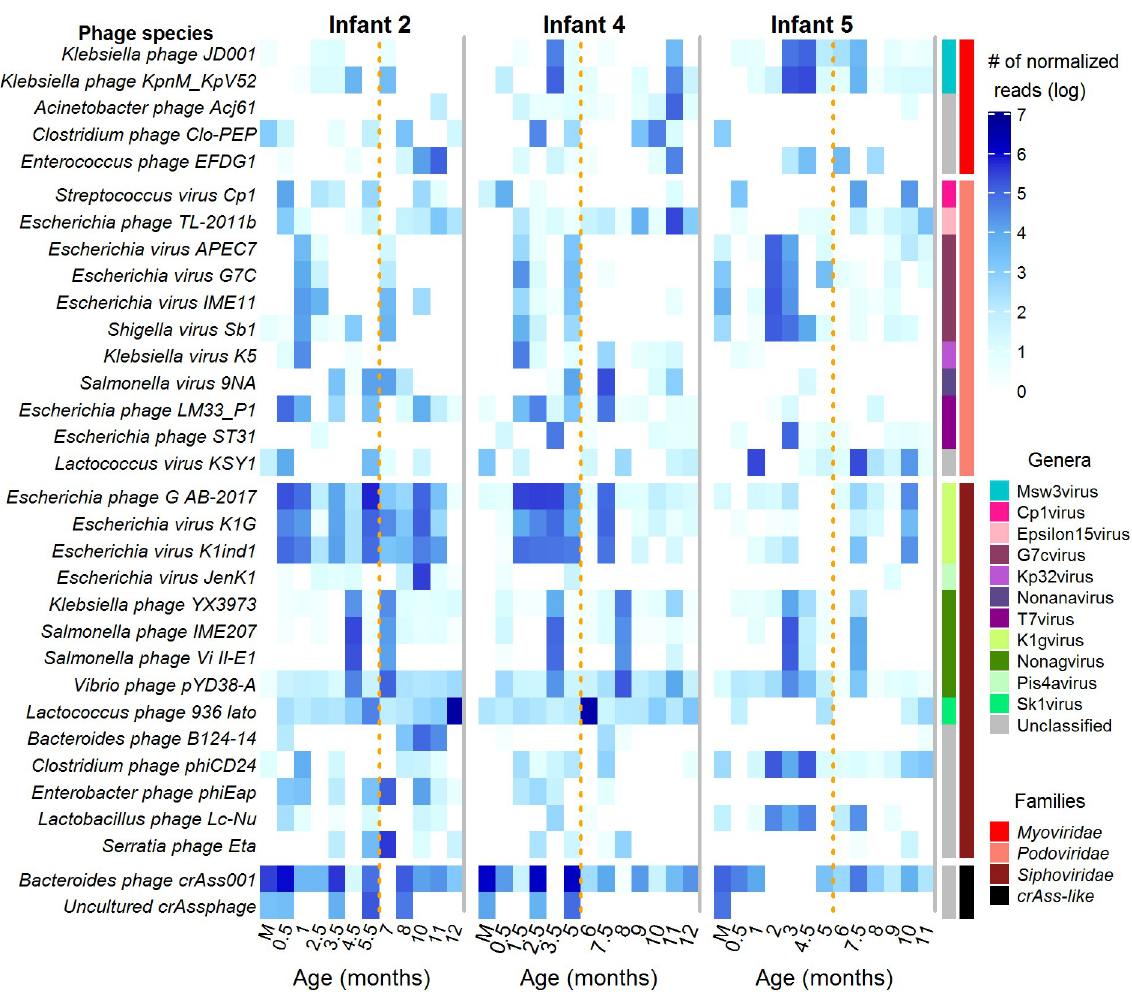
Fig 3. Normalized read abundance of the most abundant and prevalent phage species in infants during the first year of life and their mothers. Samples from infants are indicated according to their age in months and from mothers as M. The family for each phage species is indicated on the right side. The name of the phage species is listed on the left